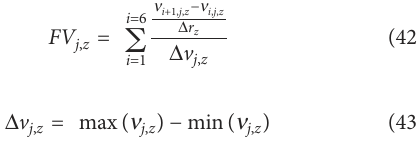
TABLE 6 Range of values explored in sensitivity analysis.